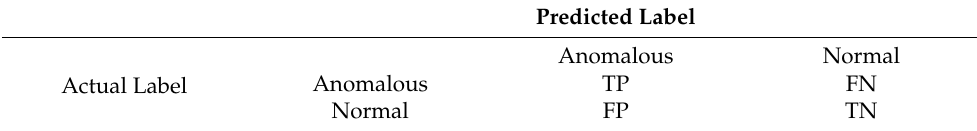
Table 5. 2 × 2 confusion